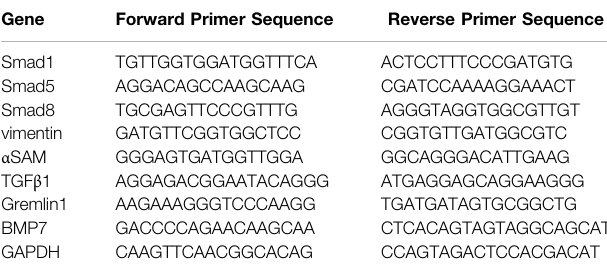
TABLE 1 | Primers for reverse transcription-quantitative polymerase chain reaction